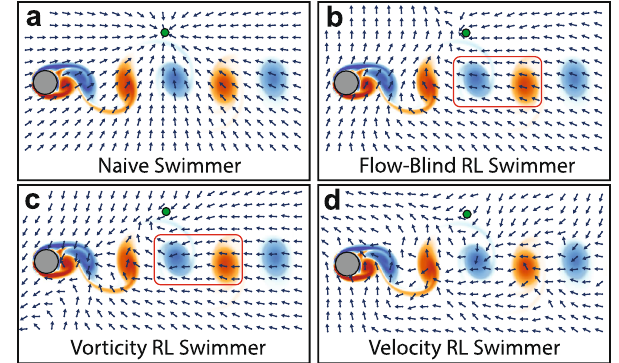
Fig. 5 Swimming direction policy plotted across the domain for a fi xed target (green circle) at a given time instant. a The naive swimmer swims towards the target. b The red outline highlights how the fl ow-blind swimmer navigates irrespective of the background fl ow, while the vorticity swimmer c adjusts its swimming direction modestly. d The velocity swimmer appears even more sensitive to the unsteady background fl